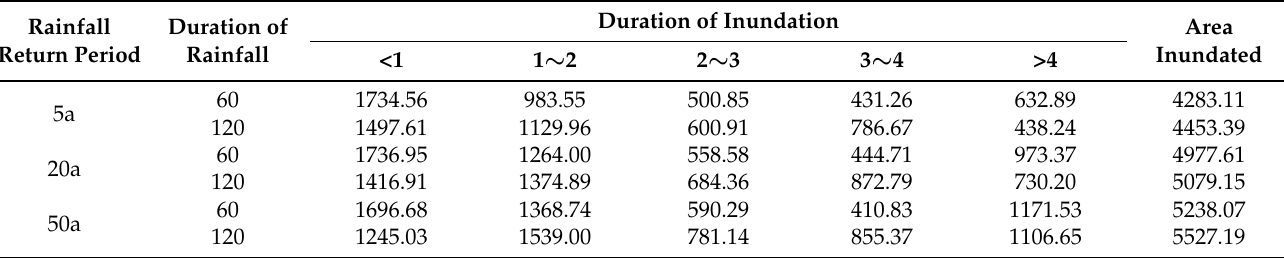
Figure 6. Simulated inundation durations and inundation ranges. Table 3. Flooded area statistics for different scenarios